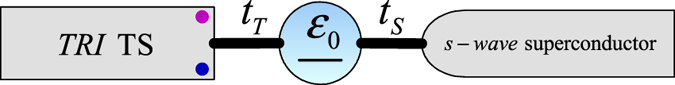
The junction formed by DIII-class topological and s-wave superconductors.One QD is embedded in the junction.